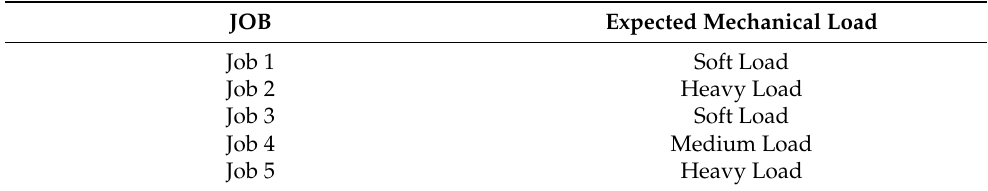
Table 1. Technician completed example of mechanical load of the monitored